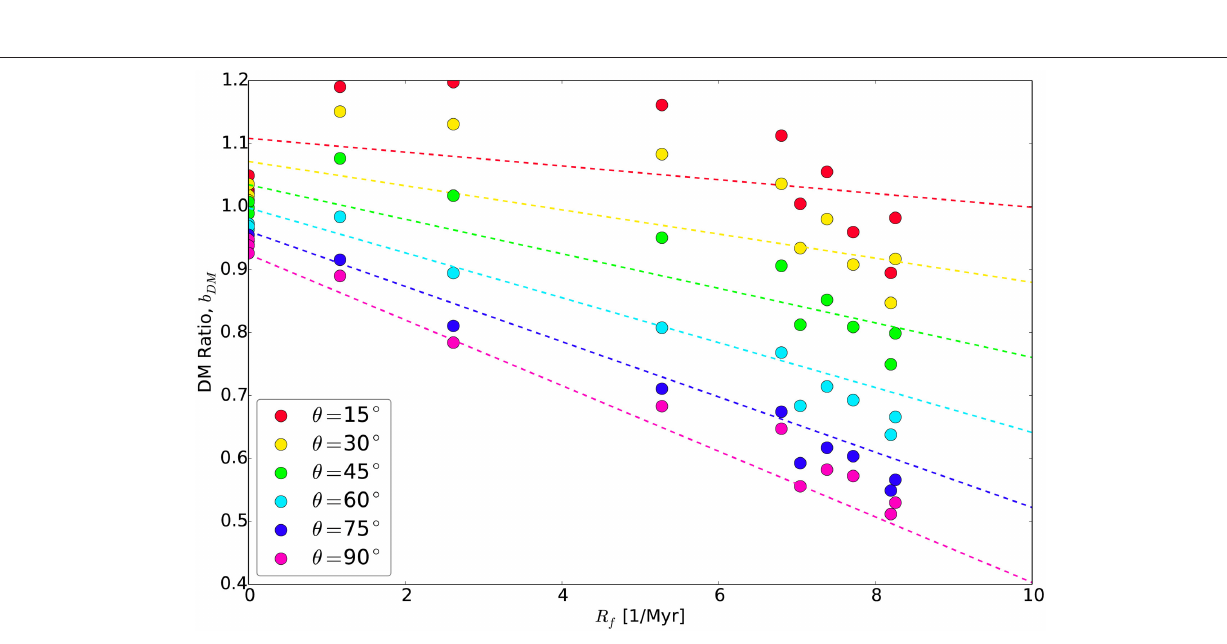
Frontiers in Earth Science |